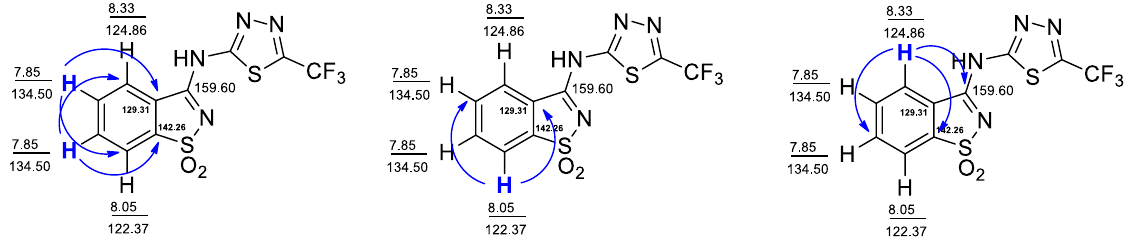
Figure 1. Main HMBC ( 3 J) correlations and assignments of signals (ppm) in the 1 H and 13 C NMR spectra of compound AL14.